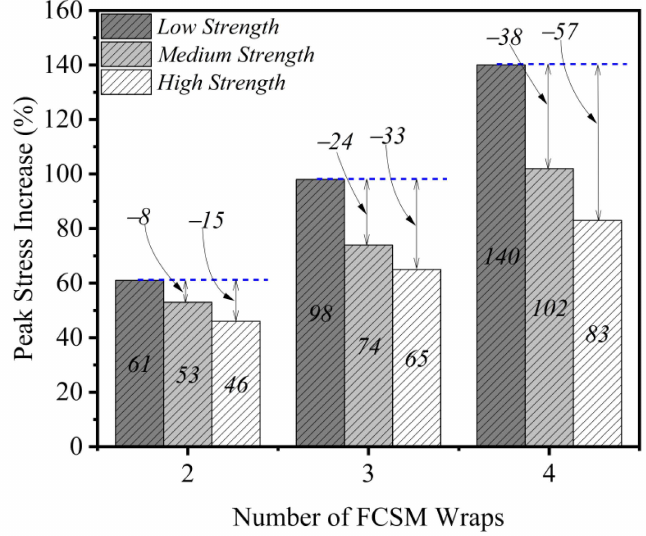
Figure 10. Effect of FCSM wraps and concrete strength on the increase in peak compressive